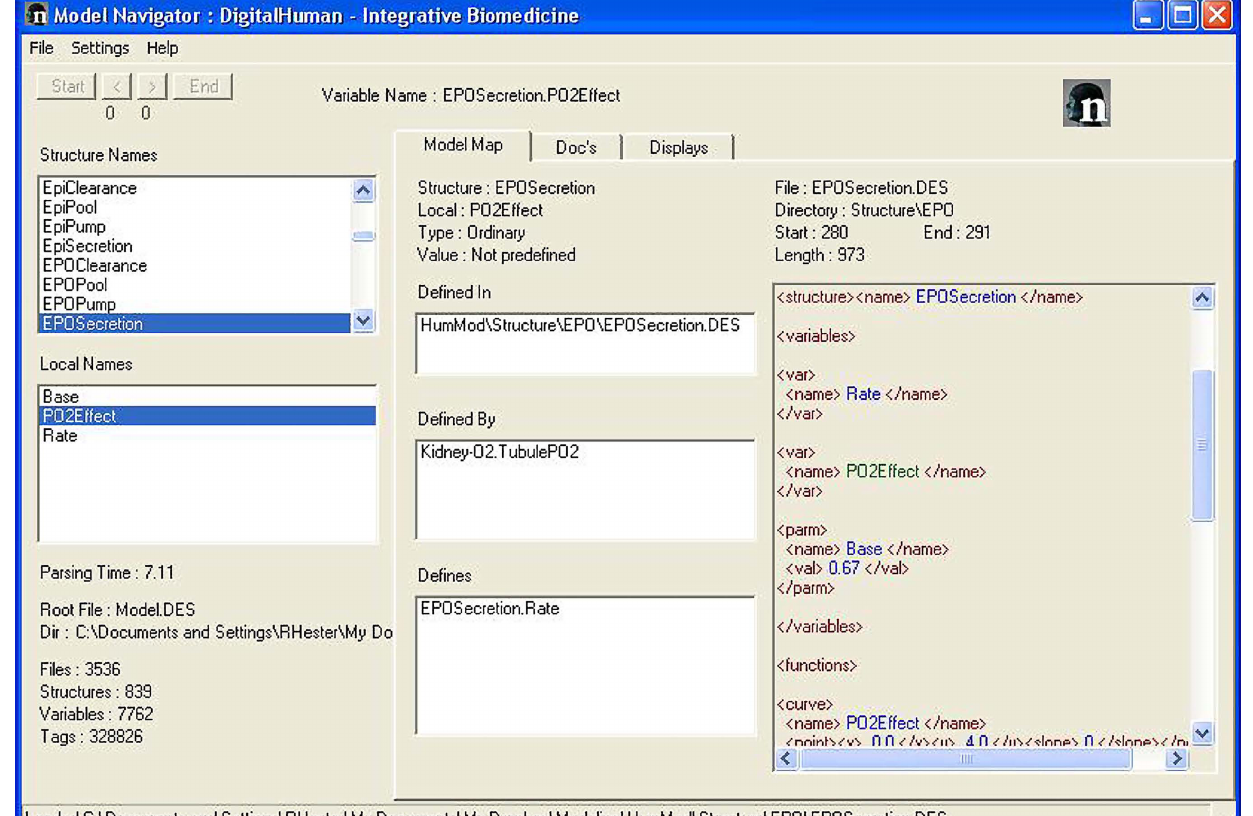
FigurE 2 | The Model Navigator is used to understand the physiological interactions and the documentation of HumMod. The left side panels list all of the variables in HumMod. The Center panels describe the interactions between each variable. The right panel shows the file location where a variable